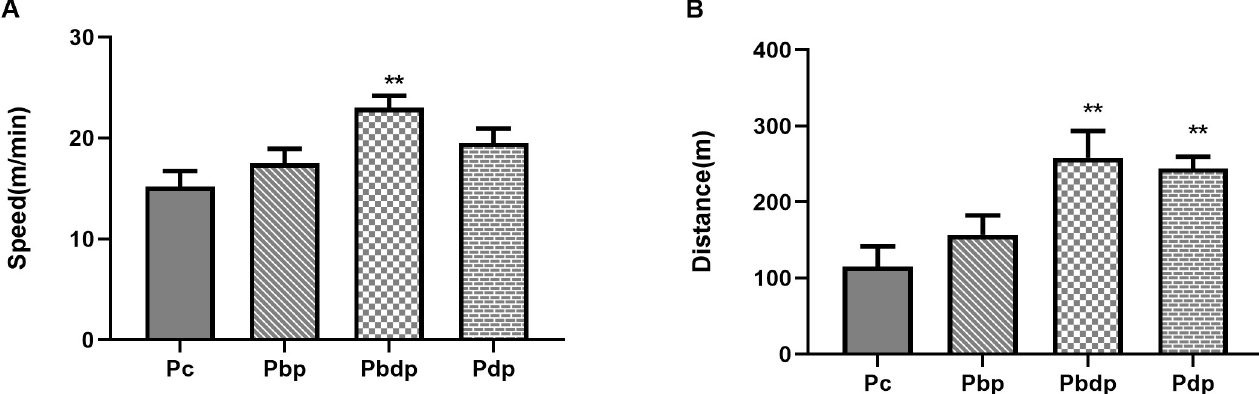
Fig 3. Comparison of exercise test among the pup groups. (A) A maximum speed of adult male offspring, (B) A maximum distance of adult male offspring. Abbreviations: P c group (n = 5), pups of sedentary mothers; P bp group (n = 6), pups of mothers who exercise only before pregnancy; P bdp group (n = 4), pups of mothers who exercise prior to and during pregnancy; P dp group (n = 6), pups of mothers who exercise only during pregnancy. Data presented as means ± S. E.M. �� p < 0.01 vs. Pup Control group. One-way ANOVA followed by Dunnett’s multiple comparisons test.